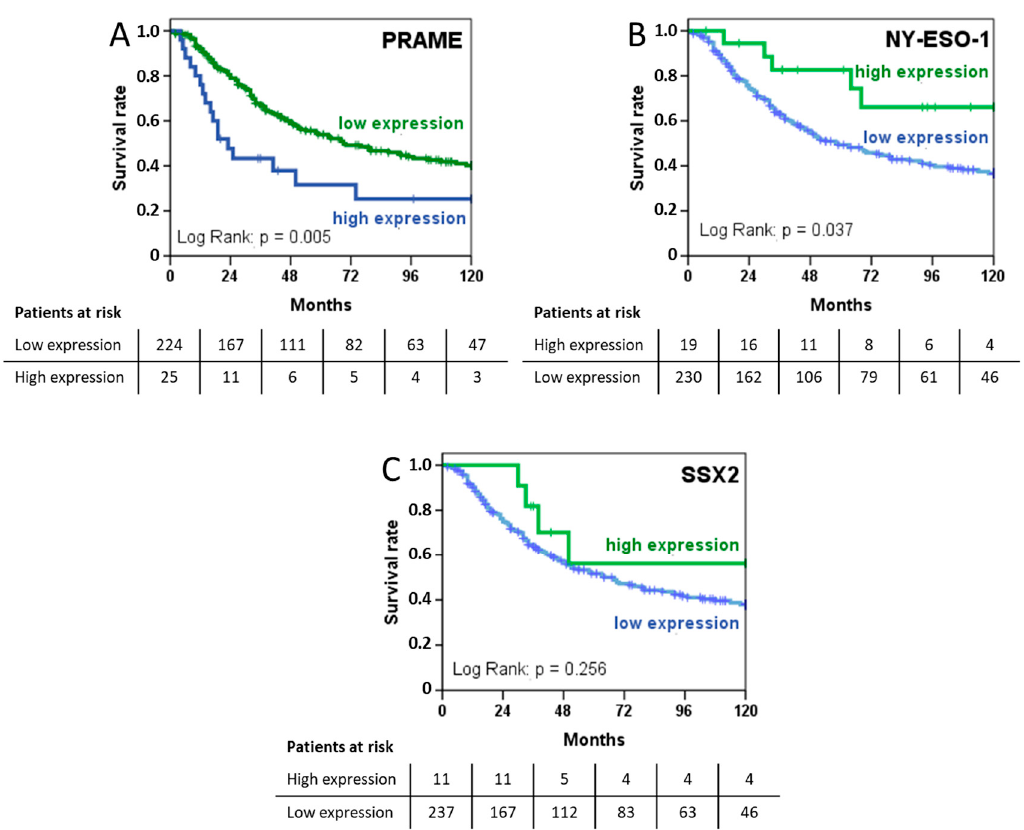
Figure 4. Univariate analysis of overall survival depicted as Kaplan–Meier curves stratified